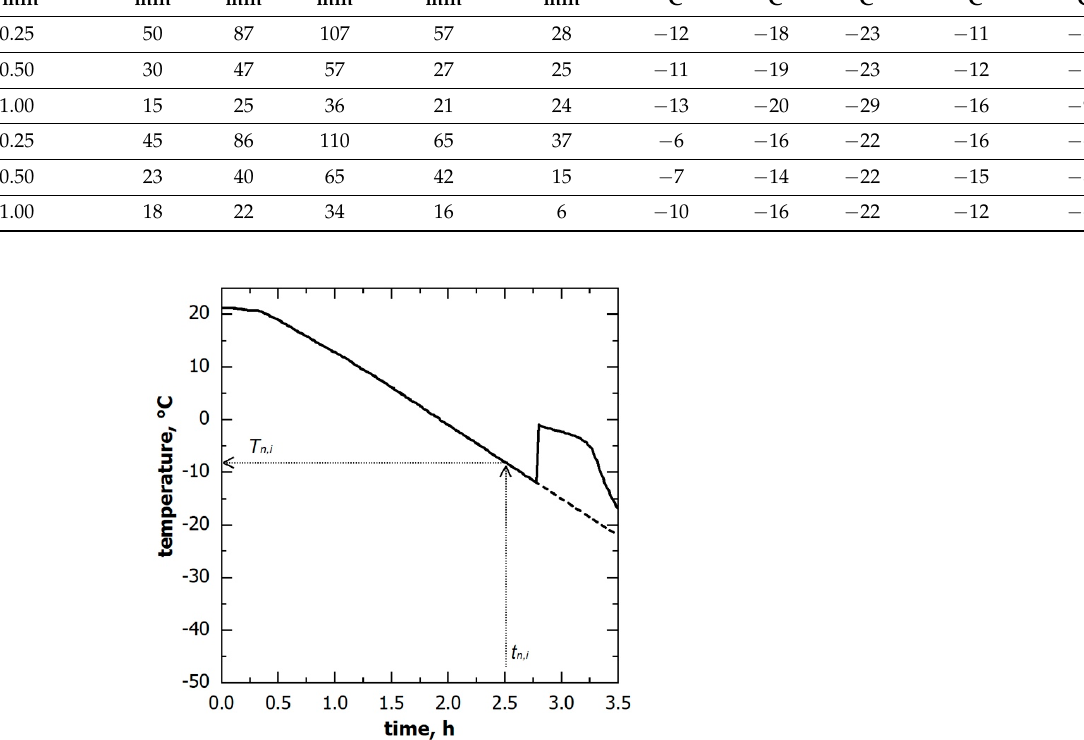
Figure 2. Cumulative distribution for the ice nucleation time in the case of vials in direct contact with the shelf. Data refer to various cooling rates: ( ▲ ) 0.25, ( □ ) 0.50, and ( ● ) 1.00 °C min − 1 . Table 1. Percentile values of the cumulative nucleation time and temperature distributions. Loading Config.